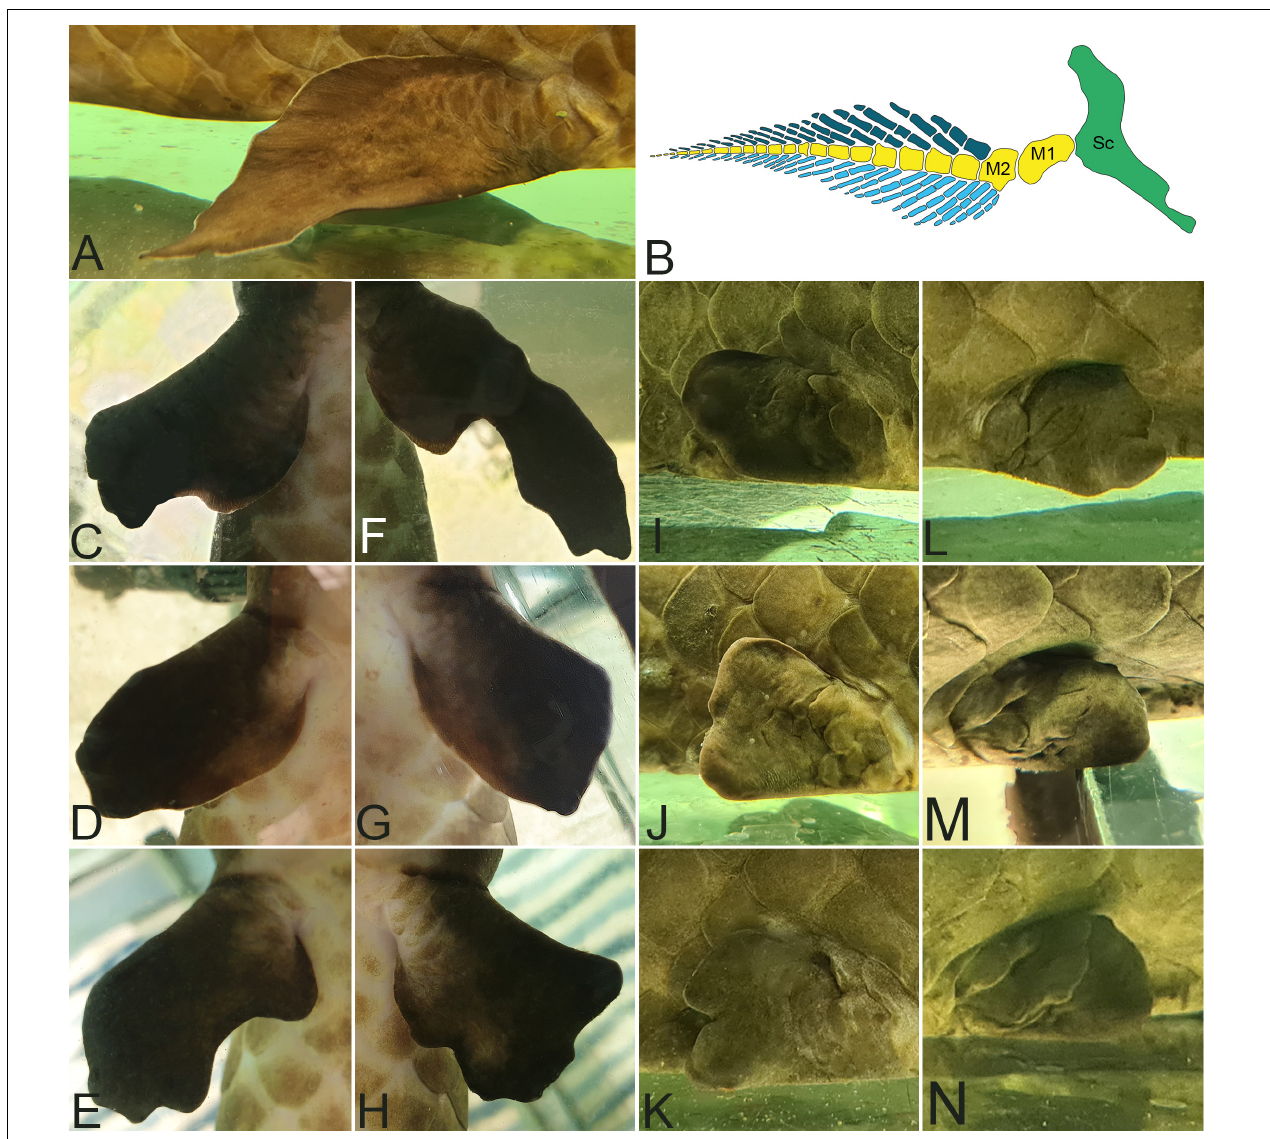
FIGURE 4 | Neoceratodus fosteri : (A) leaf-like shape of a not regenerated pelvic fin (B) Model of a Skeleton anatomy of a not regenerated pectoral lungfish fin. Sc, scapula in green; M, Mesomere in yellow. Preaxial radials in dark blue. Postaxial radial in light blue. (C–H) Left and right pectoral fins with deformations in ventral view. (I–N) Left and right pelvic fins with deformations in lateral